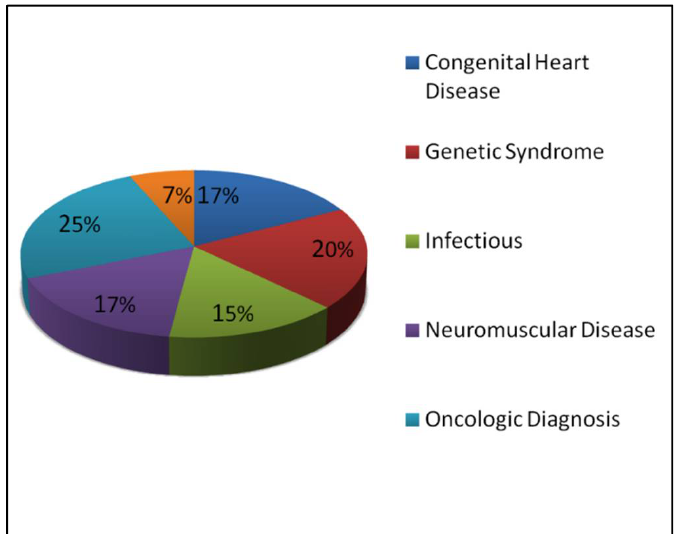
Figure 1. Diagnostic categories of deceased patients during the study period.